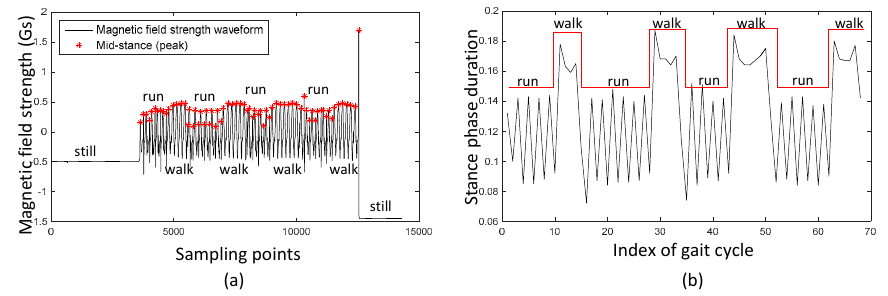
Figure 26. Mid-stance and stance phase duration of Mix_1; ( a ) is magnetic field strength waveform and mid-stances (peaks) extracted from this wave; ( b ) is stance phase duration with different gait cycles. Peak-peak information can represent movement patterns including walking and running. Stance phase duration is calculated according to peak-peak information. Table 5. Total travelled distance of SHOE and mag-ZUPT.